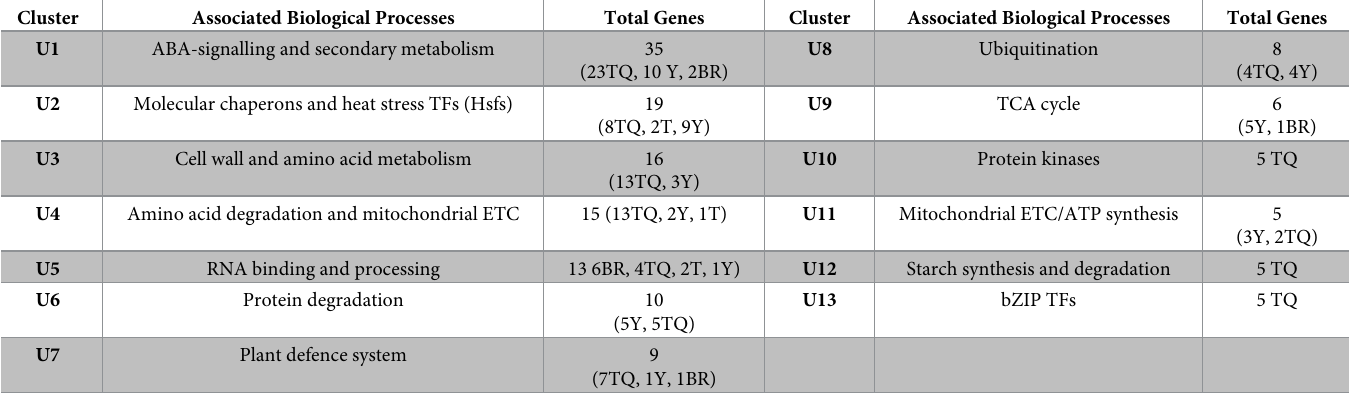
Table 4. Functional enrichment of gene clusters identified in up-regulated drought tolerant network (uDTN) using MCL algorithm. (TQ: Turquoise, Y: Yellow, BR: Brown, T: Tan).